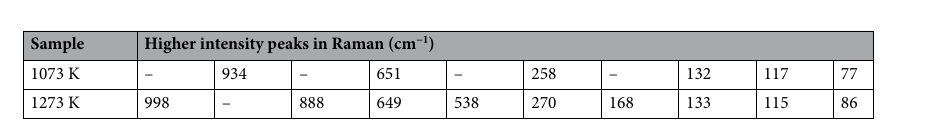
Table 4. Raman displacement of the highest intensity peaks for the calcined SiTiNb-A samples.